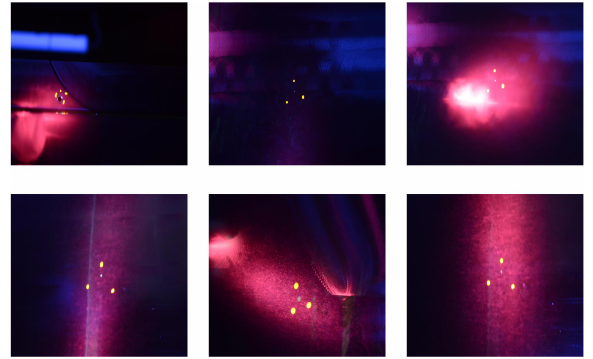
Figure 6. Baseline images with defects on wing